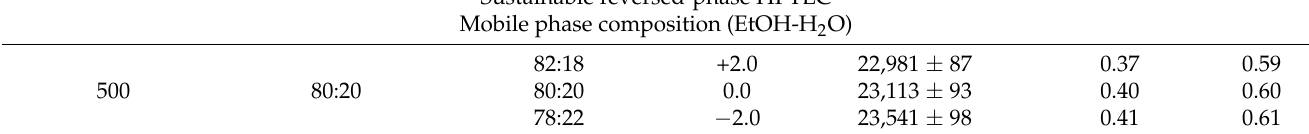
Table 5. Results of robustness analysis after modifying the mobile compositions for the routine normal-phase HPTLC and the sustainable reversed-phase HPTLC techniques (mean ± SD; n = 6). Conc.